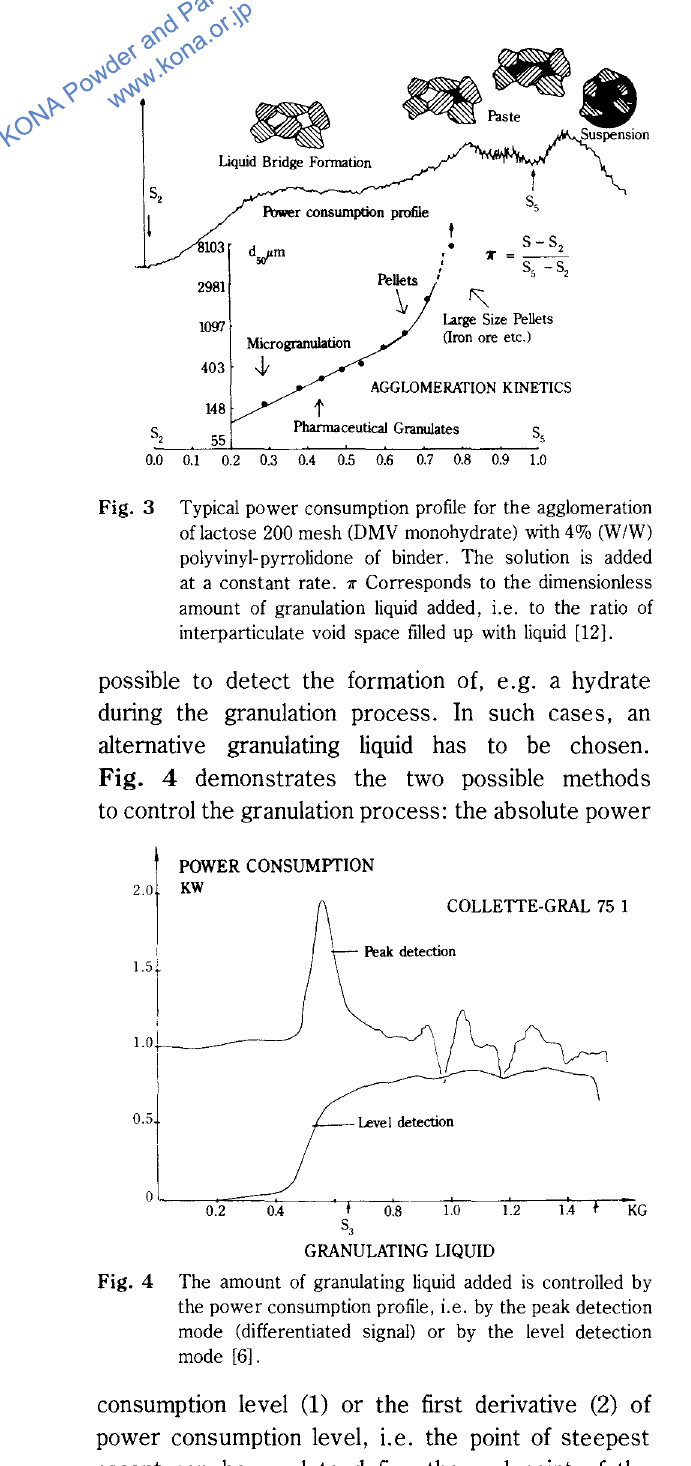
The amount of granulating liquid added is controlled by the power consumption profile, i.e. by the peak detection mode (differentiated signal) or by the level detection mode